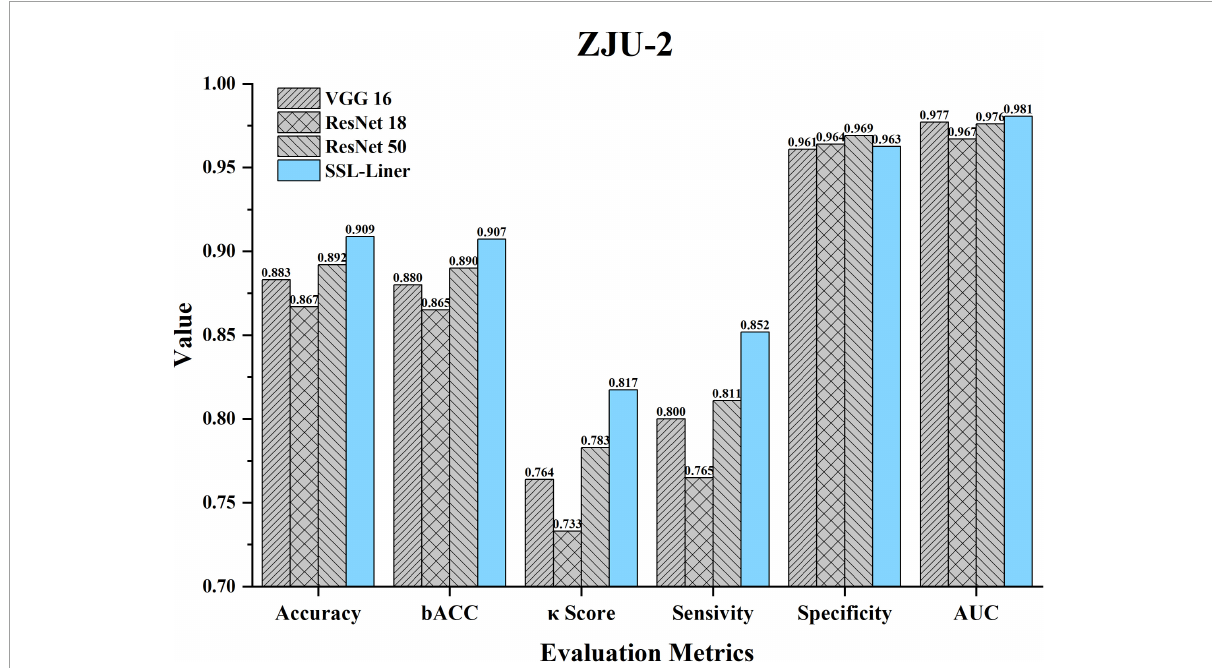
FIGURE3 Comparison of different metrics for SSL-linear and 5 CNNs at the patch-level testing set of ZJU-2. κ , unweighted Cohen’s kappa; Acc, accuracy; AUC, area under the receiver operating characteristic curve; B_Acc, balanced accuracy; CNN, convolutional neural network; ZJU-2, The